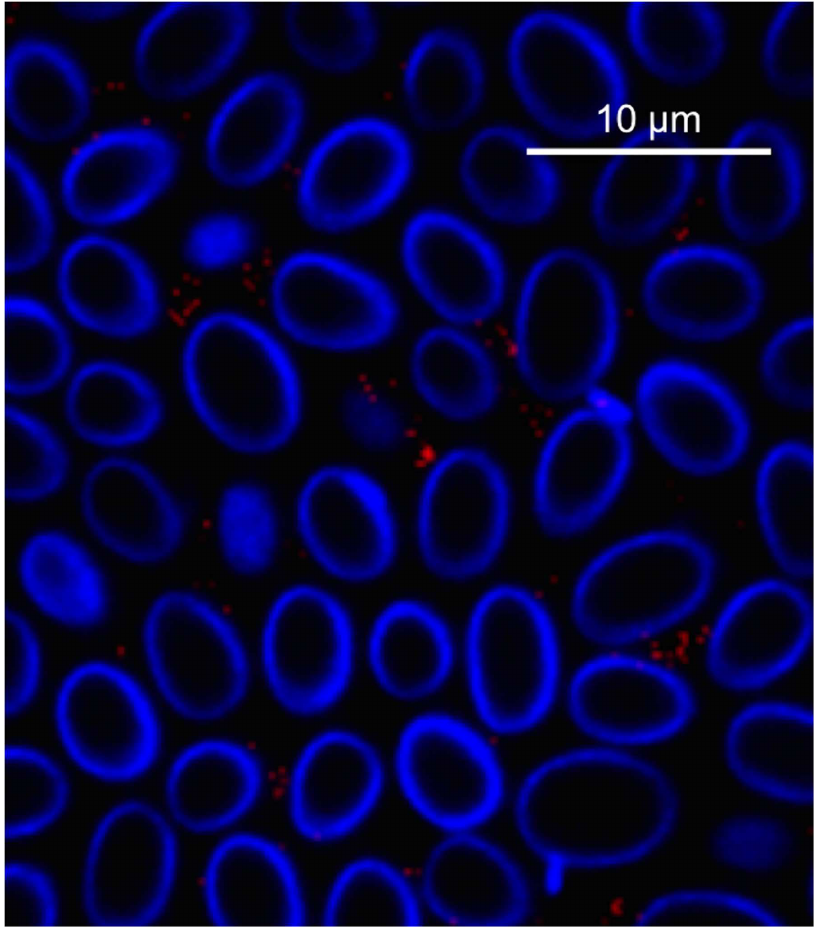
pLC003(mCherry, red) at 60 × magnification and zoomed to 200%. Amoebaspores were stainedwith